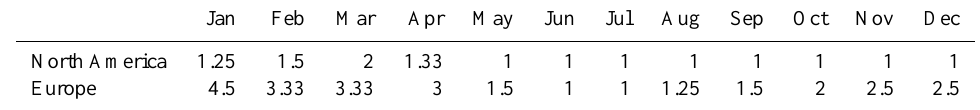
Table 4. Monthly scaling factors for CO traffic emissions over North America and Europe as applied in simulation